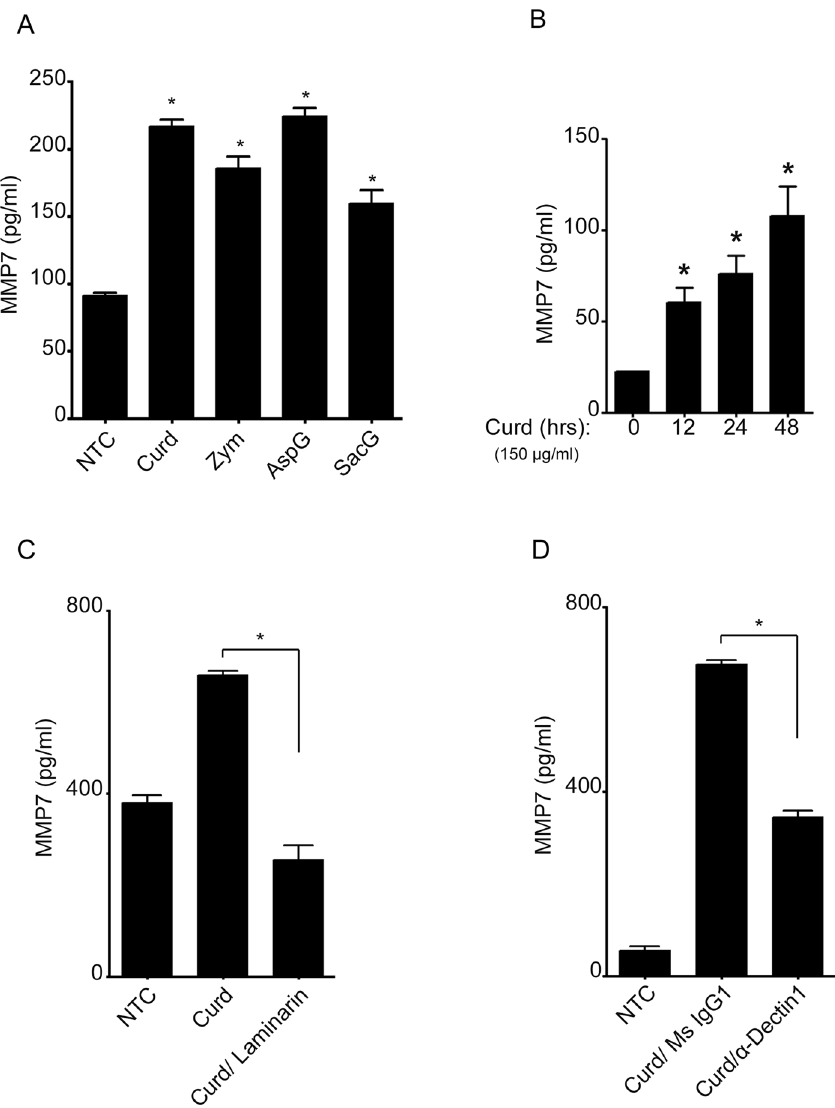
Figure 5. β -glucans induce MMP7 via Dectin-1. MMP-7 was measured by ELISA in the cell supernatant of B-lymphocytes after stimulation with different β -glucan preparations: Curdlan (Curd), Zymosan (Zym), Aspergillus fumigatus (AspG) and Saccharomyces cerevisiae (SacG) ( A ) and after stimulation with Curdlan for different periods of time ( B ). MMP-7 measured by ELISA of B-lymphocytes pre-incubated with laminarin (1 mg/ml) ( C ) ; or anti-Dectin-1 antibody ( 5 μ g/ml) ( D ). Data are representative of at least three independent experiments. * p <